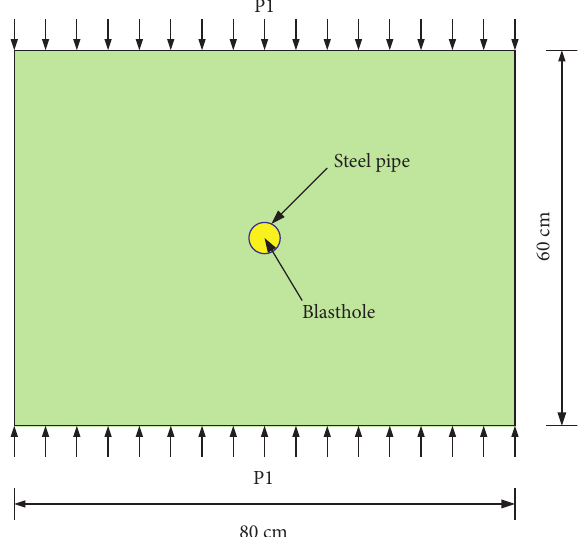
Figure 9: The numerical model of dynamic and static coupling of the parent